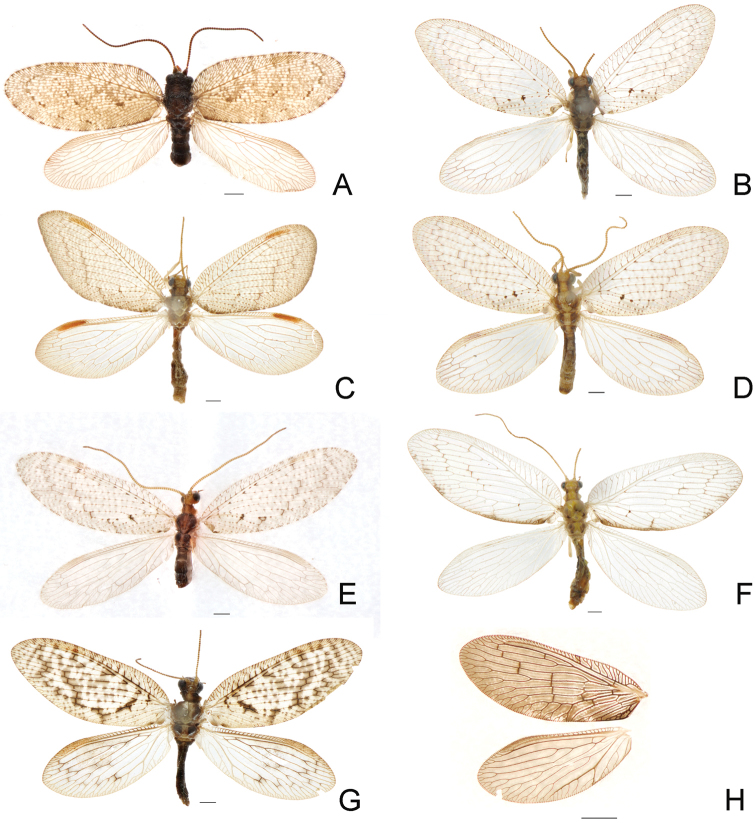
Habitus photographs of species of Hemerobiidae newly recorded from Beijing. ADrepanepteryxalgida (Erichson, 1851) BHemerobiusbispinus Banks, 1940 CHemerobiusexoterus Navás, 1936 DHemerobiushumulinus Linnaeus, 1758 EHemerobiusjaponicus Nakahara, 1915 FHemerobiusmarginatus (Stephens, 1836) GHemerobiussubtriangulus Yang, 1987 HSympherobiusmanchuricus Nakahara, 1960. Scale bar: 1 mm.